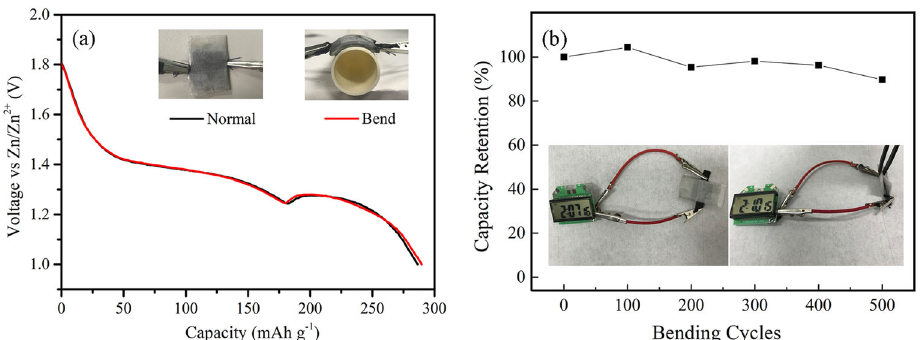
Fig. 4 Flexible Zn – MnO 2 /rGO battery. a Discharge curves under normal and bending conditions. b The bending test of the fl exible Zn – MnO 2 / rGO battery for 500 cycles. Inset shows the fl exible Zn – MnO 2 /rGO battery powers a timer under normal and 180 degrees of bending